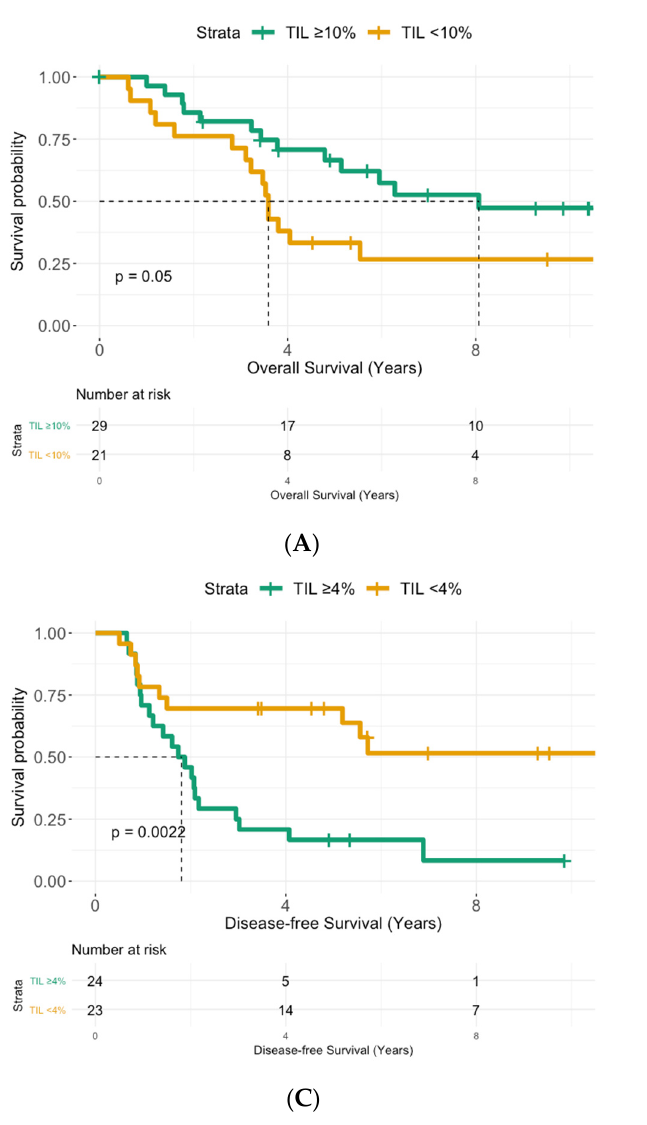
Figure 3. Kaplan–Meier curves for OS ( A , B ) and DFS ( C , D ) in IBC. A. Patients with ≥ 10% sTIL before NACT have a significant longer OS: Median survival of 8.07 year (95% CI: 5.14–NR) vs. 3.59 year (95% CI: 3.11–NR), p = 0.05 B. More sTIL after NACT ( ≥ 4%) is associated with a shorter OS: Median survival of 3.78 year (95% CI: 3.22–NR) vs. NR year (95% CI: 3.80–NR), p = 0.057. C. Patients with ≥ 4% sTIL after NACT have a significant shorter DFS: Median survival of 1.81 year (95% CI: 1.21–2.95) vs. NR year (95% CI: 5.19–NR), p = 0.002. D. A higher residual cellularity ( ≥ 17.5%) in the tumour bed is associated with a shorter DFS: Median survival of 1.13 year (95% CI: 0.88–2.02) vs. 6.88 year (95% CI: 3.02–NR), p < 0.001.